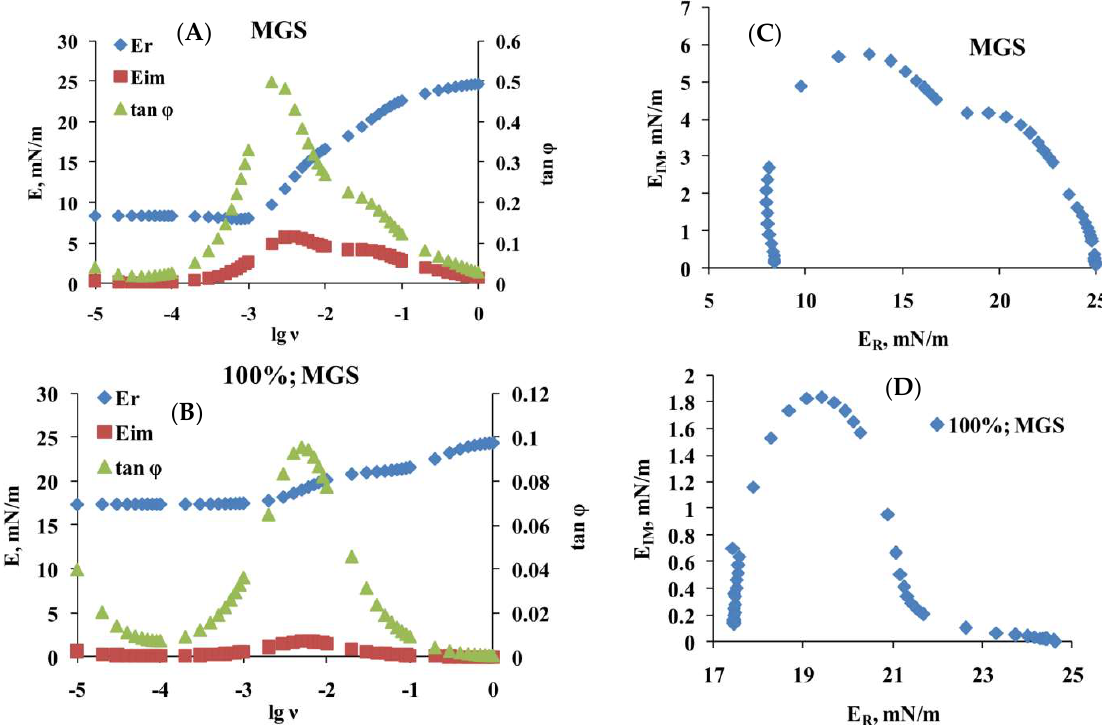
Figure 5. Rheological parameters obtained via Fourier transformation ( A and B ) and Cole-Cole (E R vs E IM ) plots ( C and D ) of intact and 100% saturated MGS films, respectively. The results for 25, 50, and 67% saturated MGS are presented as a Supplementary file.